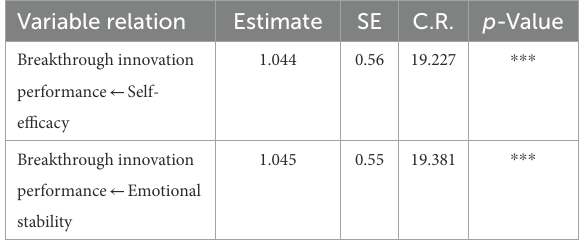
TABLE 6 Regression coefficient of main effect path.